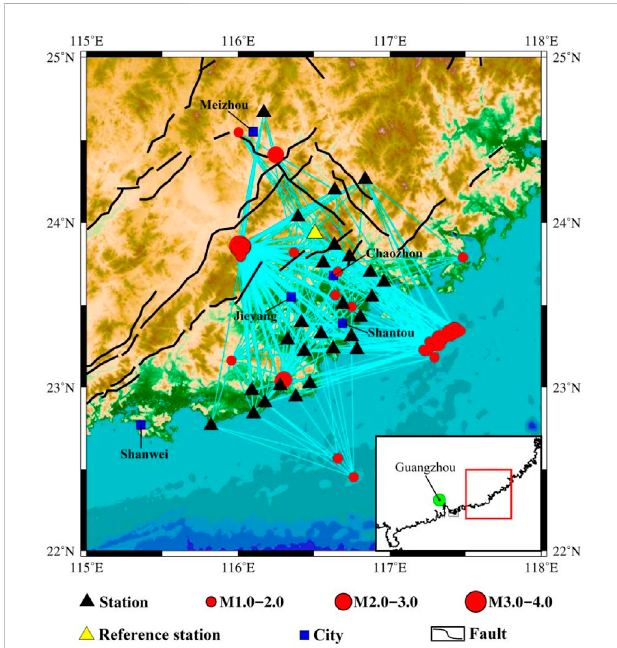
FIGURE 1 The locations of earthquakes (red circles) and stations (triangles) used in this study. The yellow triangle indicates the location of reference station FSLHX. The black discontinuous solid lines represent the faults. Thecyanlinesdenotethepropagationpathfromeventstostations. The small scale map in the southeast shows the location and scope of the study